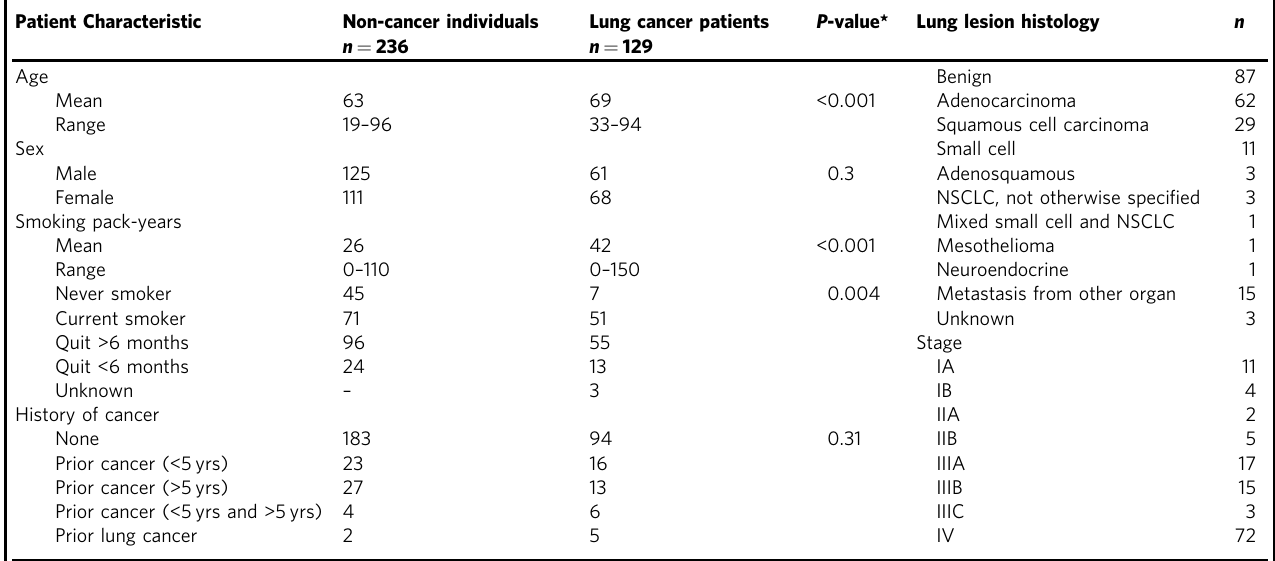
* P -values were calculated to compare data from individuals with and without lung cancer for the following variables: mean ages and smoking pack years using Student ’ s unpaired two-tailed t -tests, sex distribution using a χ 2 test, and smoking status and history of cancer using one-way